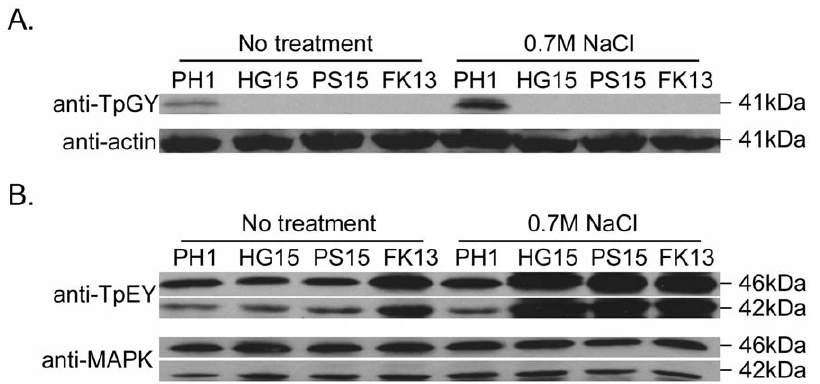
Figure 8. Assays for the activation of FgHog1, Mgv1, and Gpmk1 MAP kinases. Total proteins were isolated from vegetative hyphae of the wild type (PH-1) and the Fghog1 (HG15), Fgpbs2 (PS15), and Fgssk2 (FK13) mutants. A. The anti-TpGY antibody was used to detect the phosphorylation of FgHog1 (41-kDa) in cultures treated with or without 0.7 M NaCl. B. Phosphorylation of Mgv1 (46-kDa) and Gpmk1 (42-kDa) was detected with the anti-TpEY antibody. Anti-actin and anti-MAPK antibodies were used to determine the same loading amount of protein.